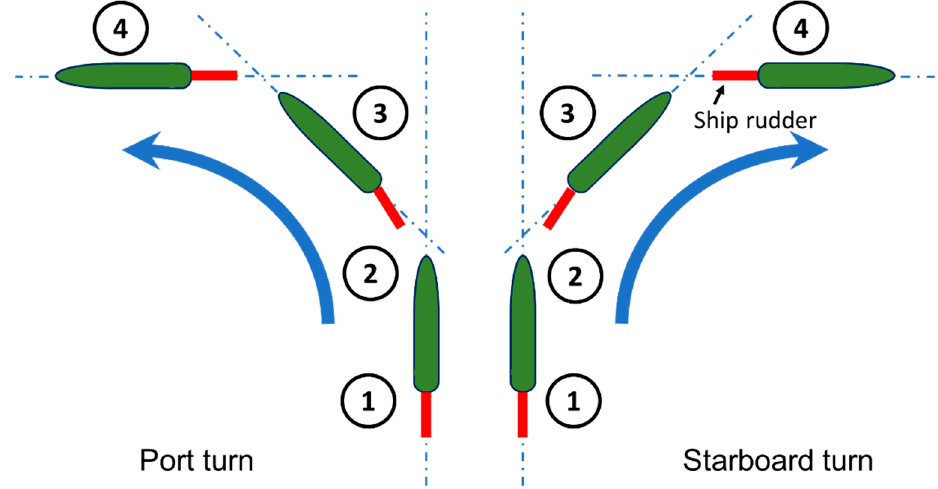
Figure 6. Sea-trial procedure of the case ship. ( 1 ) Rudder angle 0 degrees; ( 2 ) Rudder angle changes from 0 to 12 degrees (port or starboard); ( 3 ): Rudder angle 12 degrees; ( 4 ) Rudder angle 0 degrees.